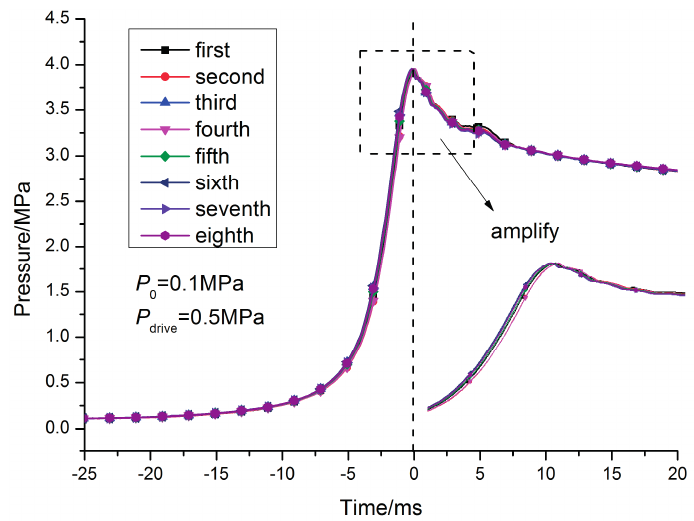
Figure 10. Demonstration of experimental repeatability for